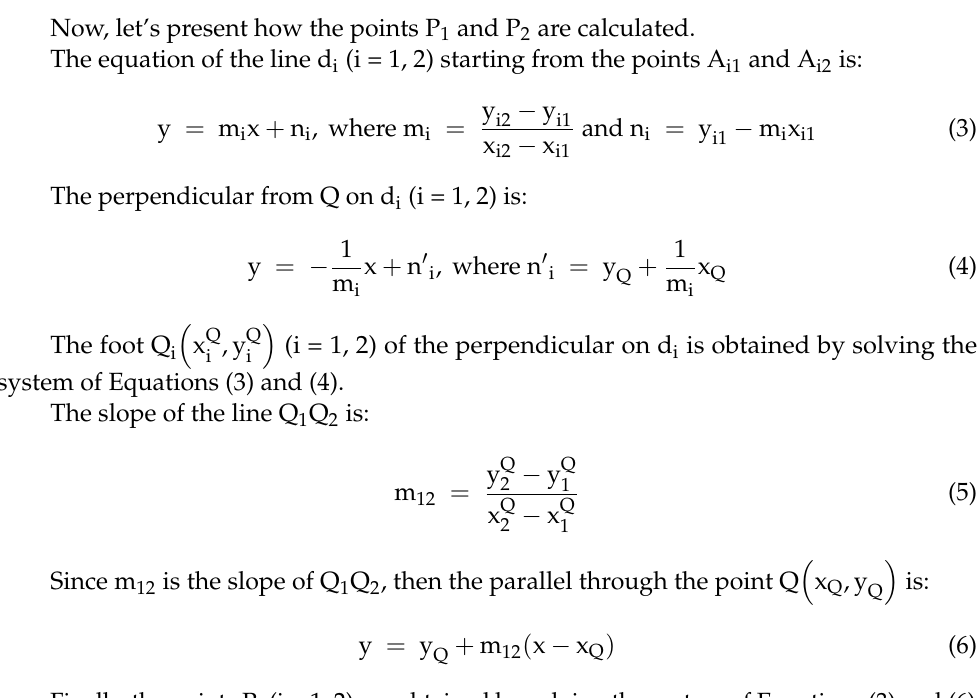
Figure 5. Approximate method of finding points P 1 and P 2 .